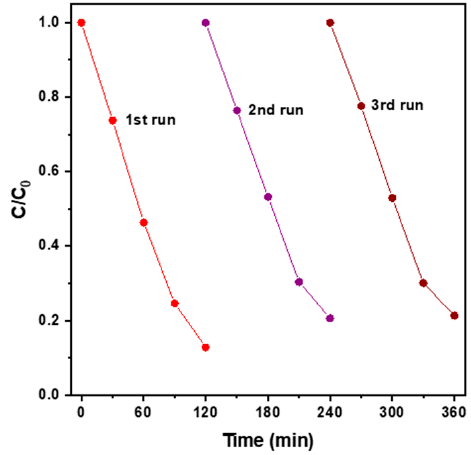
Figure 10. Stability of BiVO 4 :Mo nanoparticles in photocatalytic degradation of diluted RhB solu- tion.